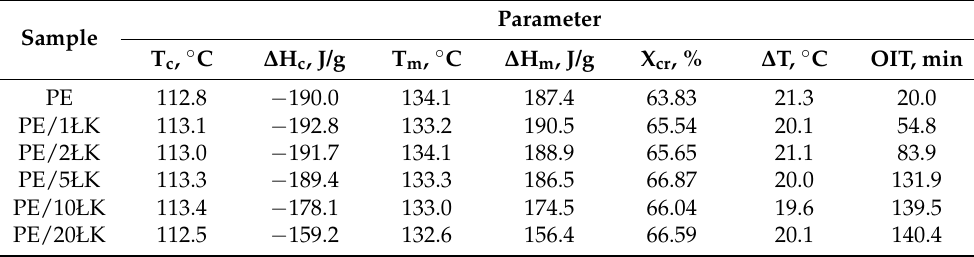
Table 2. Results of the DSC analysis of prepared